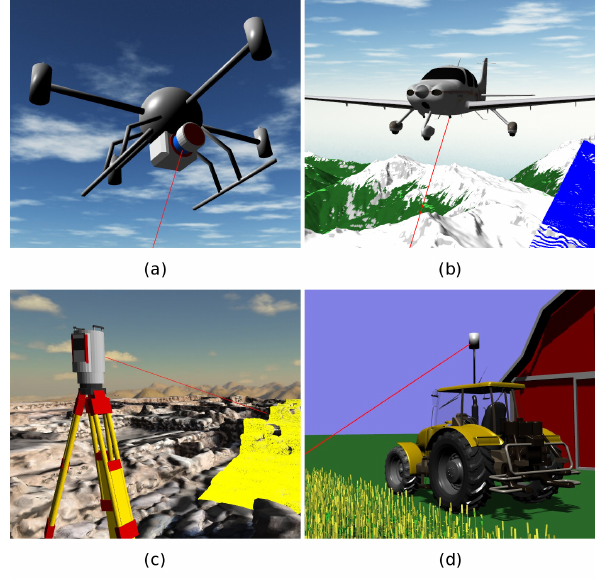
Figure 3: Surveys with different types of scanner and platforms, rendered by the visualization module: (a) quadrocopter, (b) fixed- wing aircraft, (c) tripod, (d) tractor. Aircraft 3D model: CC-BY- SA Emmanuel Barranger. Tractor 3D model: tf3dm.com (free for personal